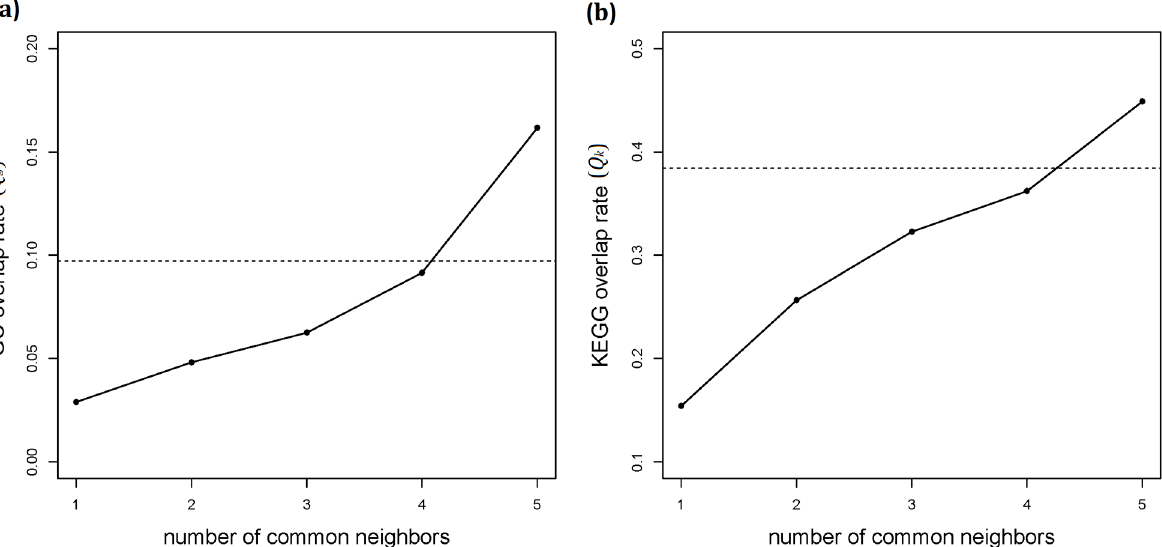
Fig 2. Comparison between direct interactions and indirect interactions. The x -axes are the number of common neighbors shared by proteins with only indirect interactions. The y -axes are the annotation overlap rates of GO ( a ) and KEGG ( b ). Dashed lines in both plots represent GO ( a ) and KEGG ( b ) annotation overlap rates for direct interactions. The annotation overlap rate ( Q g for GO and Q k for KEGG) was used to assess the functional associations of protein pairs (see Materials and Methods for the definition).